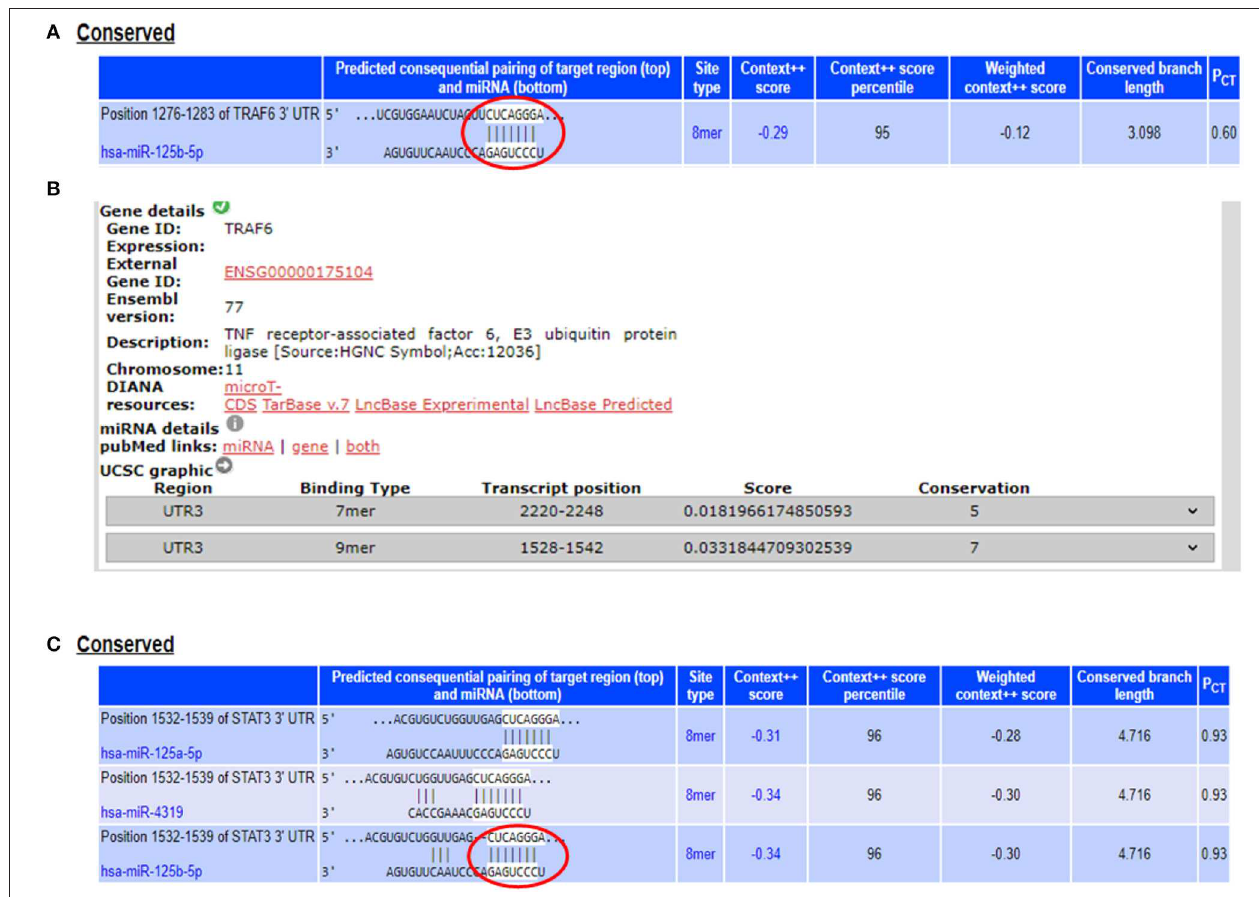
FIGURE 2 | miR-125b binding sites within the 3 ′ UTRs of TRAF6 and STAT3. (A) 3 ′ UTR of TRAF6 contains binding sites for miR-125b-5p at position 1276–1283 as shown by target scan (http://www.targetscan.org/cgi-bin/targetscan/vert_72/view_gene.cgi?rs=ENST00000526995.1&taxid=9606&showcnc=0&shownc=0& shownc_nc=&showncf1=&showncf2=&subset=1#miR-125-5p). (B) miR-125b binding sites within the 3 ′ UTR of TRAF6 were also shown by DIANA-microT-CDS (http://diana.imis.athena-innovation.gr/DianaTools/index.php?r=microT_CDS/results&keywords=ENSG00000175104&genes=ENSG00000175104%20&mirnas=& descr=&threshold=0.7). (C) 3 ′ UTR of STAT3 contains binding sites for miR-125b-5p at position 1532–1539 as shown by target scan (http://www.targetscan.org/cgi- bin/targetscan/vert_72/view_gene.cgi?rs=ENST00000585517.1&taxid=9606&members=&showcnc=0&shownc=0&showncf1=&showncf2=&subset=1#miR-125-